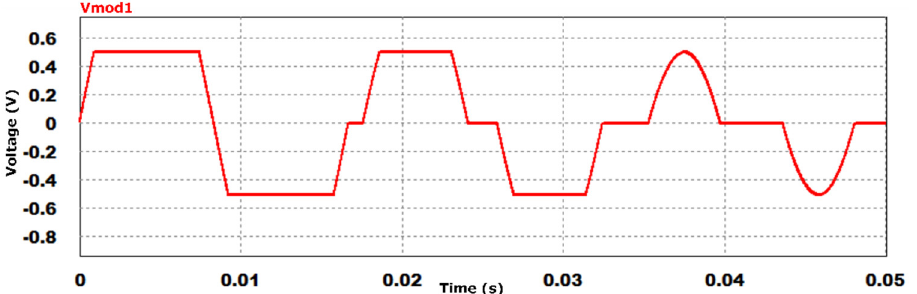
Figure 9. Modulating signal 1.